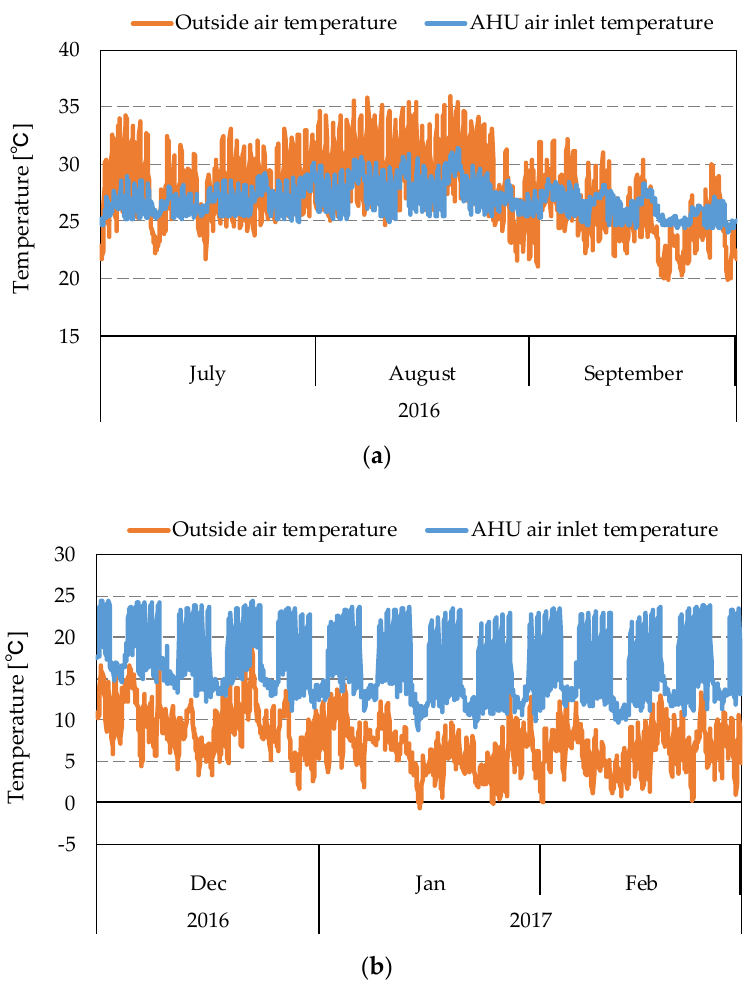
Figure 6. AHU inlet air temperature and outside air temperature. ( a ) The indoor temperature in summer and outside air temperature. ( b ) The indoor temperature in winter and outside air temperature.